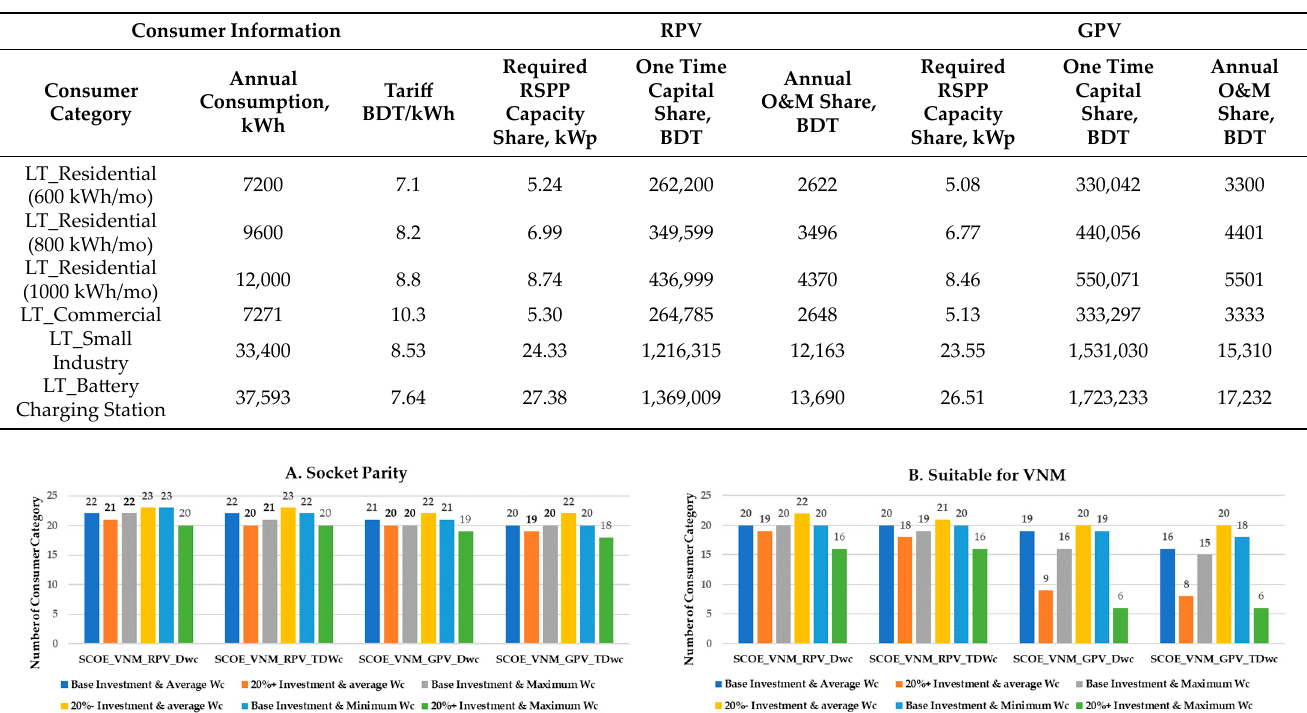
Table 10. Average annual consumption, consumer‑wise RSPP capacity shares and estimated costs.